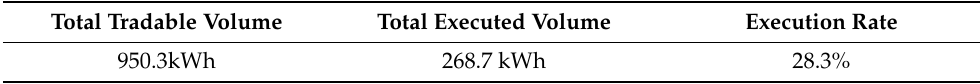
Table 3. Total volumes in the simulation without market makers.